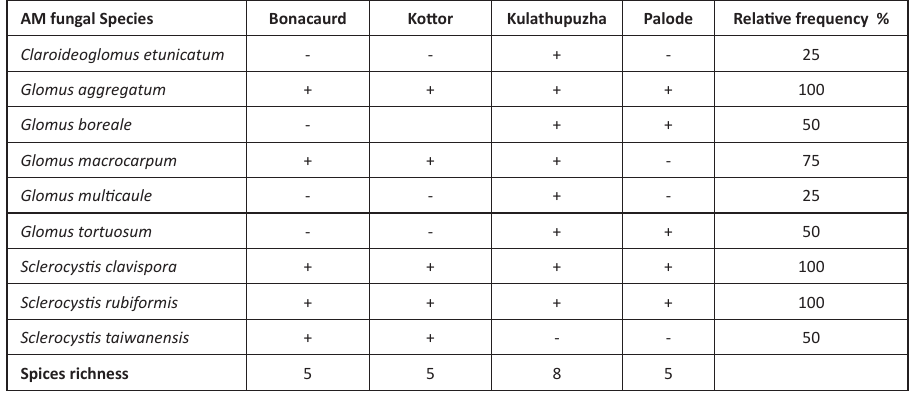
Table 1. Pattern of species richness and relative frequency of AM fungi in different habitats of Ochlandra travancorica